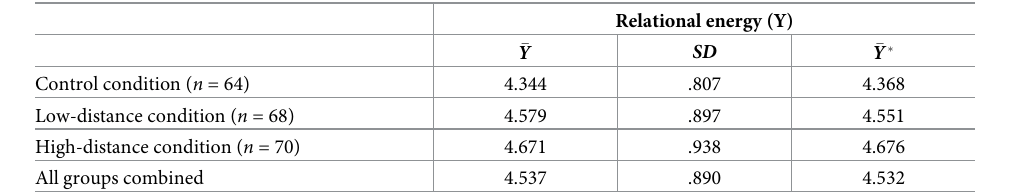
Table 1. Descriptive statistics in Study